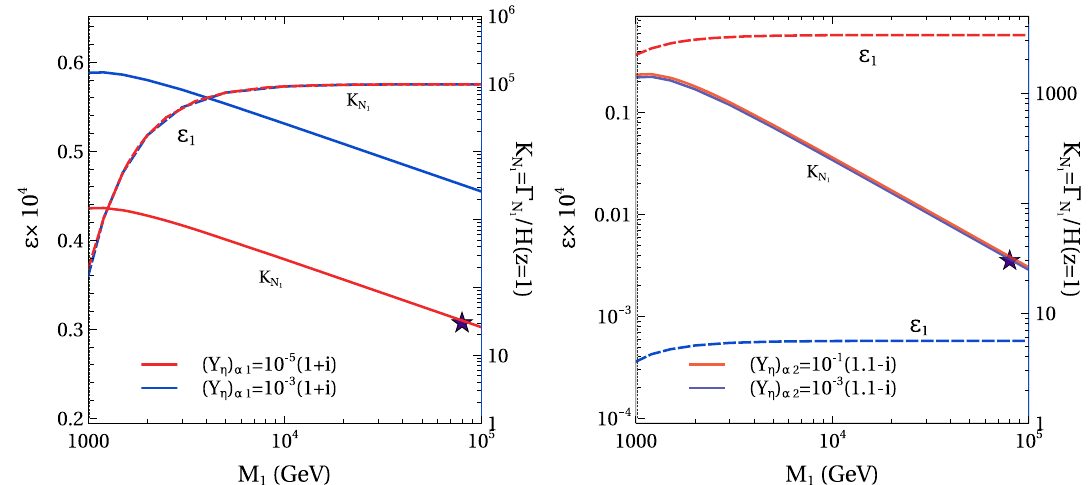
dashed lines. We fix the ( Y η ) α 2 = 10 − 1 ( 1 . 1 − i ) for the left panel and = 10 − 5 ( 1 + i ) for the right panel. The points marked as stars ( Y η ) α 1